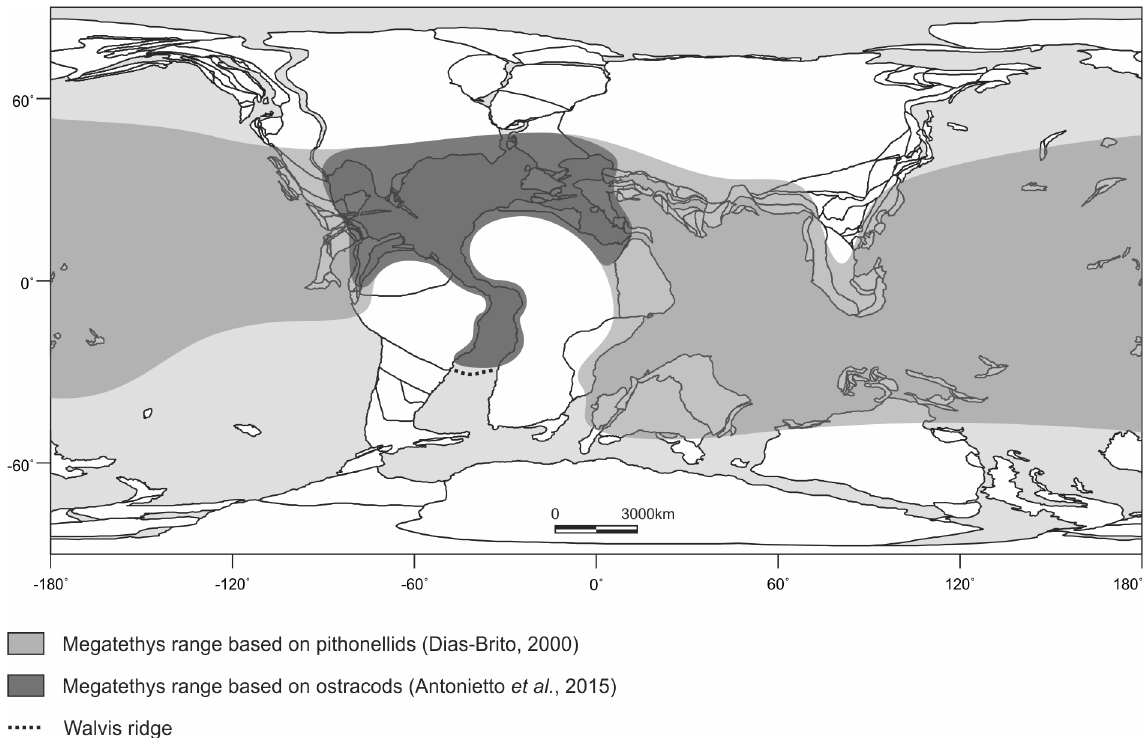
Fig. 3. Extension of the “Megatethys Ocean”, or “Mid Cretaceous Tethyan Realm”, during the